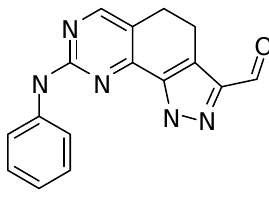
Figure 11. The most common substructure used in common substructure-based